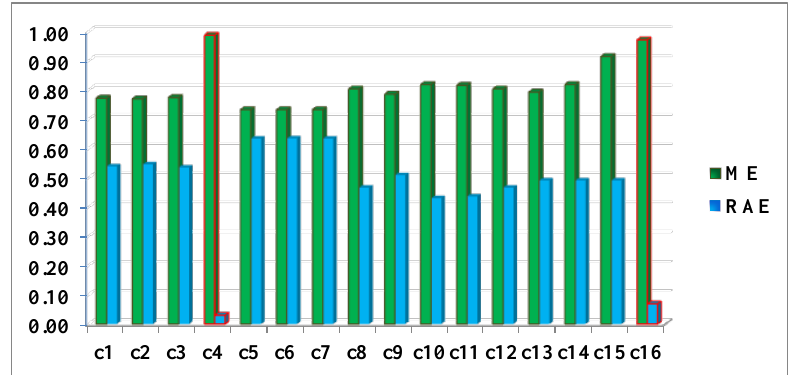
Figure 17. Missclosure (ME) and Relative Area (RAE) Errors for DS1 change maps.